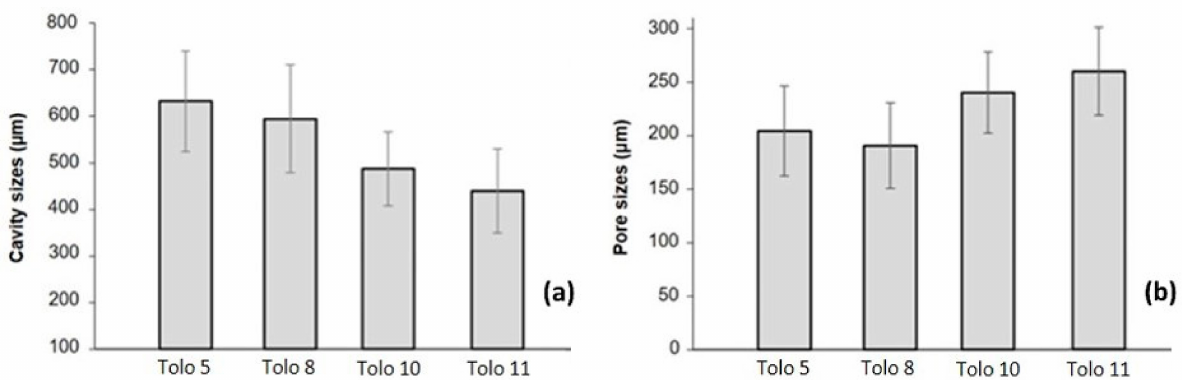
Figure 10. Average cavity ( a ) and pore ( b ) size of the PU foams.